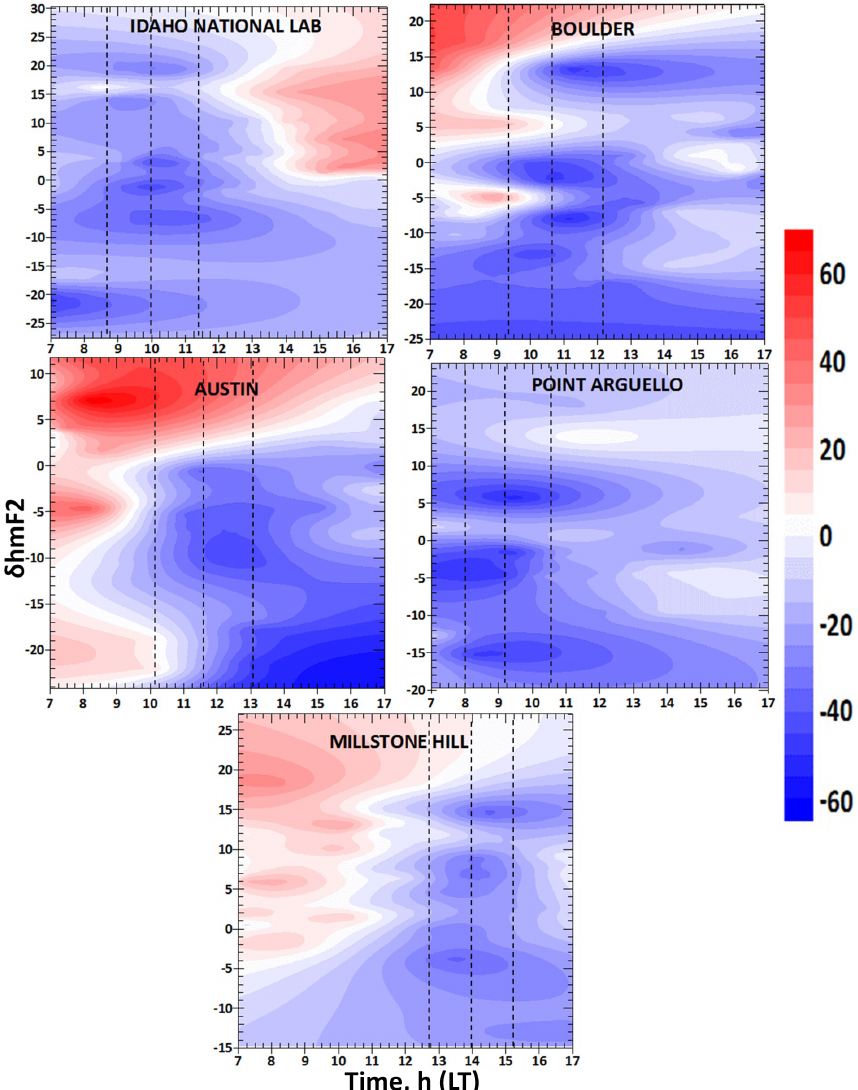
Figure 4. Variation in the deviation percentage of NmF2 ( δ NmF2 ) and hmF2 ( δ hmF2 ) magnitudes for observing the changes in the behaviour of the thermospheric composition and wind flow related to the loss rate during the eclipse phase. The three vertical dashed lines marked the eclipse start time, the time of maximum obscuration and the last contact time of the eclipse (i.e. eclipse phase). Table 1 highlights the local time contact point of the eclipse corresponding the international standard time (IST) eclipse progression. The direction of wind was identified using the δ NmF2 colour legend. The negative values represent the westward wind direction and the positive values represent the eastward